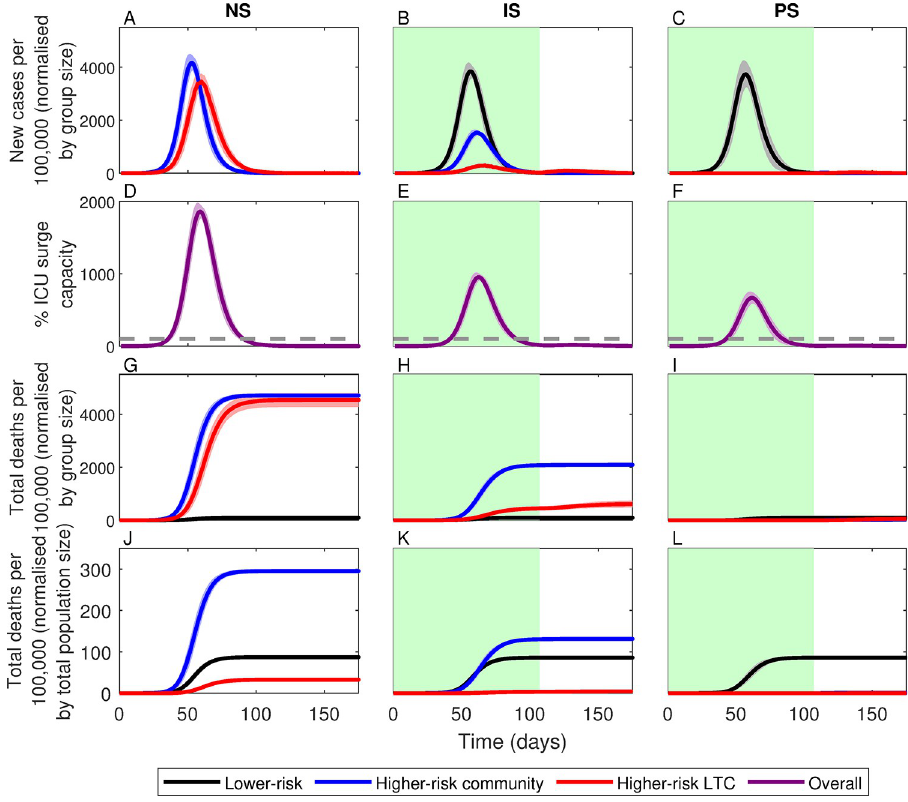
Fig 2. Simulations of no (NS), imperfect (IS) and perfect (PS) shielding. Lines correspond to means for groups at: lower-risk (black), higher-risk in the community (blue) and in LTC facilities (red), with shading indicating ± 1 SD. Green shading indicates the shielding phase. Top row: daily number of new cases per 100,000 members of each group (i.e., new cases in each group multiplied by 100,000 and divided by group size). Second row: percentage of surge capacity ICU beds in demand (horizontal dashed line indicates full capacity). Third row: cumulative number of deaths per 100,000 members of each group (i.e., total deaths in each group multiplied by 100,000 and divided by group size). Bottom row: cumulative number of deaths per 100,000 members of the total population (i.e., total deaths multiplied by 100,000 and divided by total population size). Data averaged over 100 identically initialized stochastic repeats (see Materials and methods